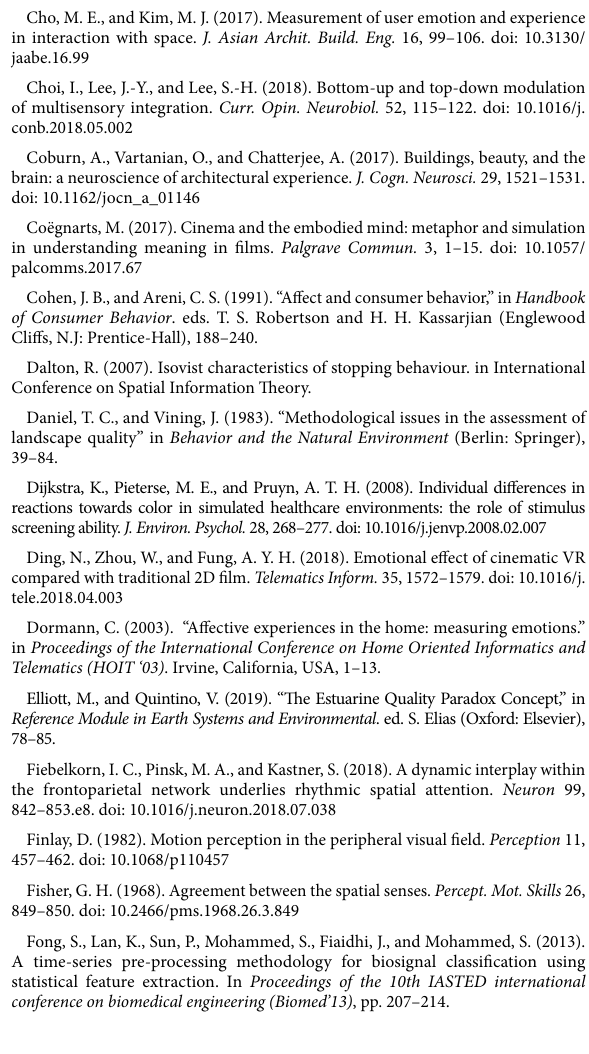
SUPPLEMENTARY TABLE 1 The Spearman correlation coefficient (95% CI) between